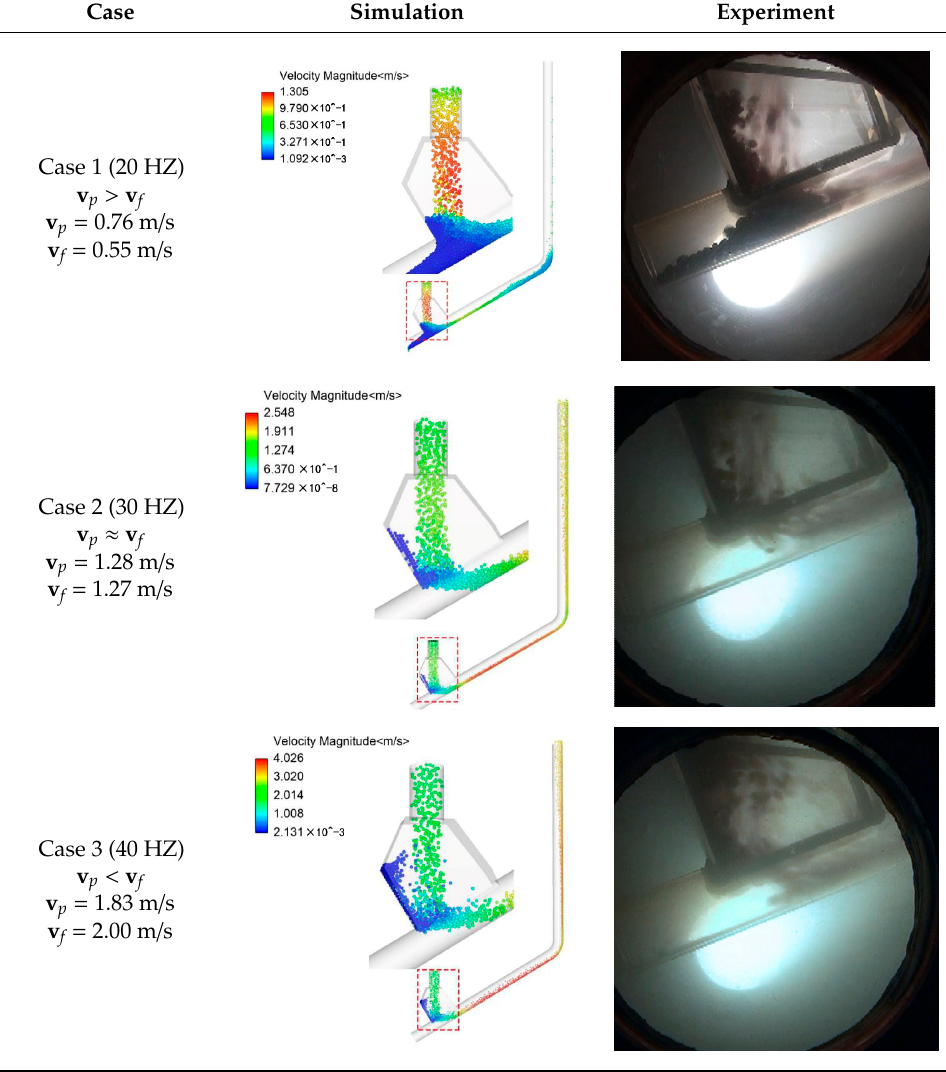
Table 6. Particle distribution in the Y-shaped elbow obtained by simulation and experiment.